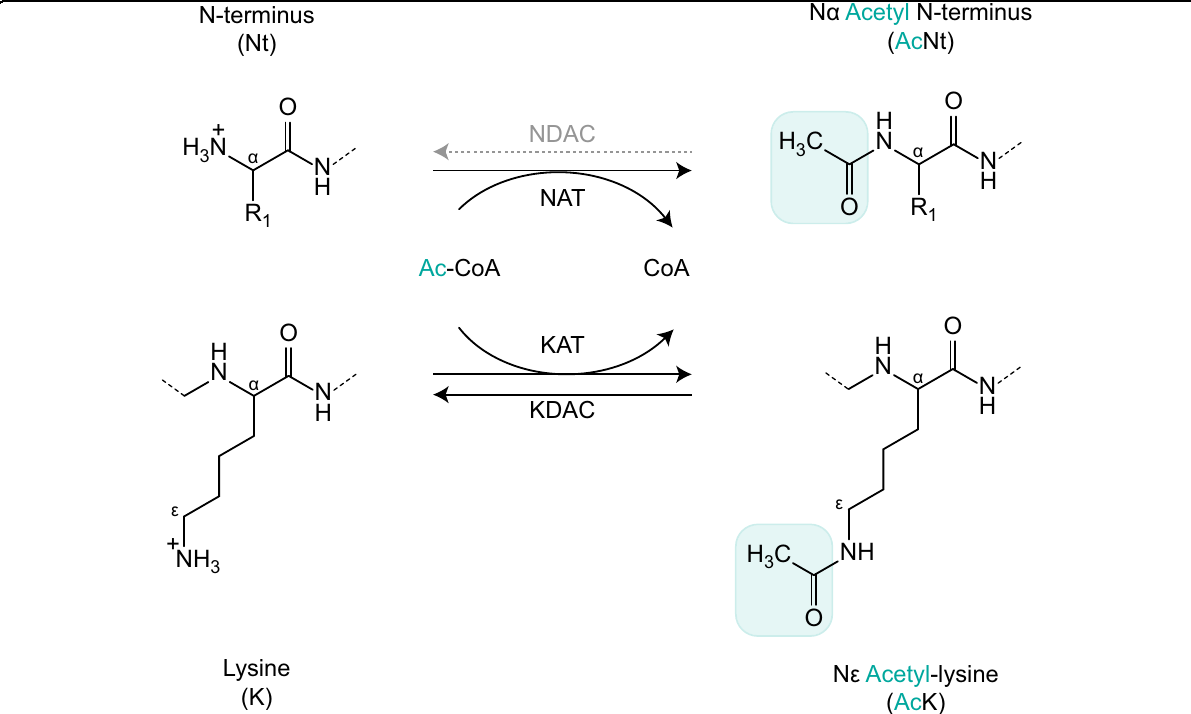
Fig. 1 Schematic outline of N-terminal and lysine protein acetylation. N-terminal acetyltransferases (NATs) and lysine acetyltransferases (KATs) catalyze the transfer of an acetyl group (CH 3 O, turquoise) from acetyl-CoA (Ac-CoA) to the free α -amino group of protein N-termini and to the ε - amino group of lysine (K) side chains, respectively. Covalent attachment of an acetyl group eliminates the positive charge ( + ) of the amino group, thus affecting local electrostatic properties. Nt-acetylation is considered irreversible because an N-terminal deacetyltransferase (NDAC) remains to be discovered. In the case of lysine acetylation, the acetyl moiety may be removed by lysine deacetyltransferases (KDACs), making it a reversible protein modi fi